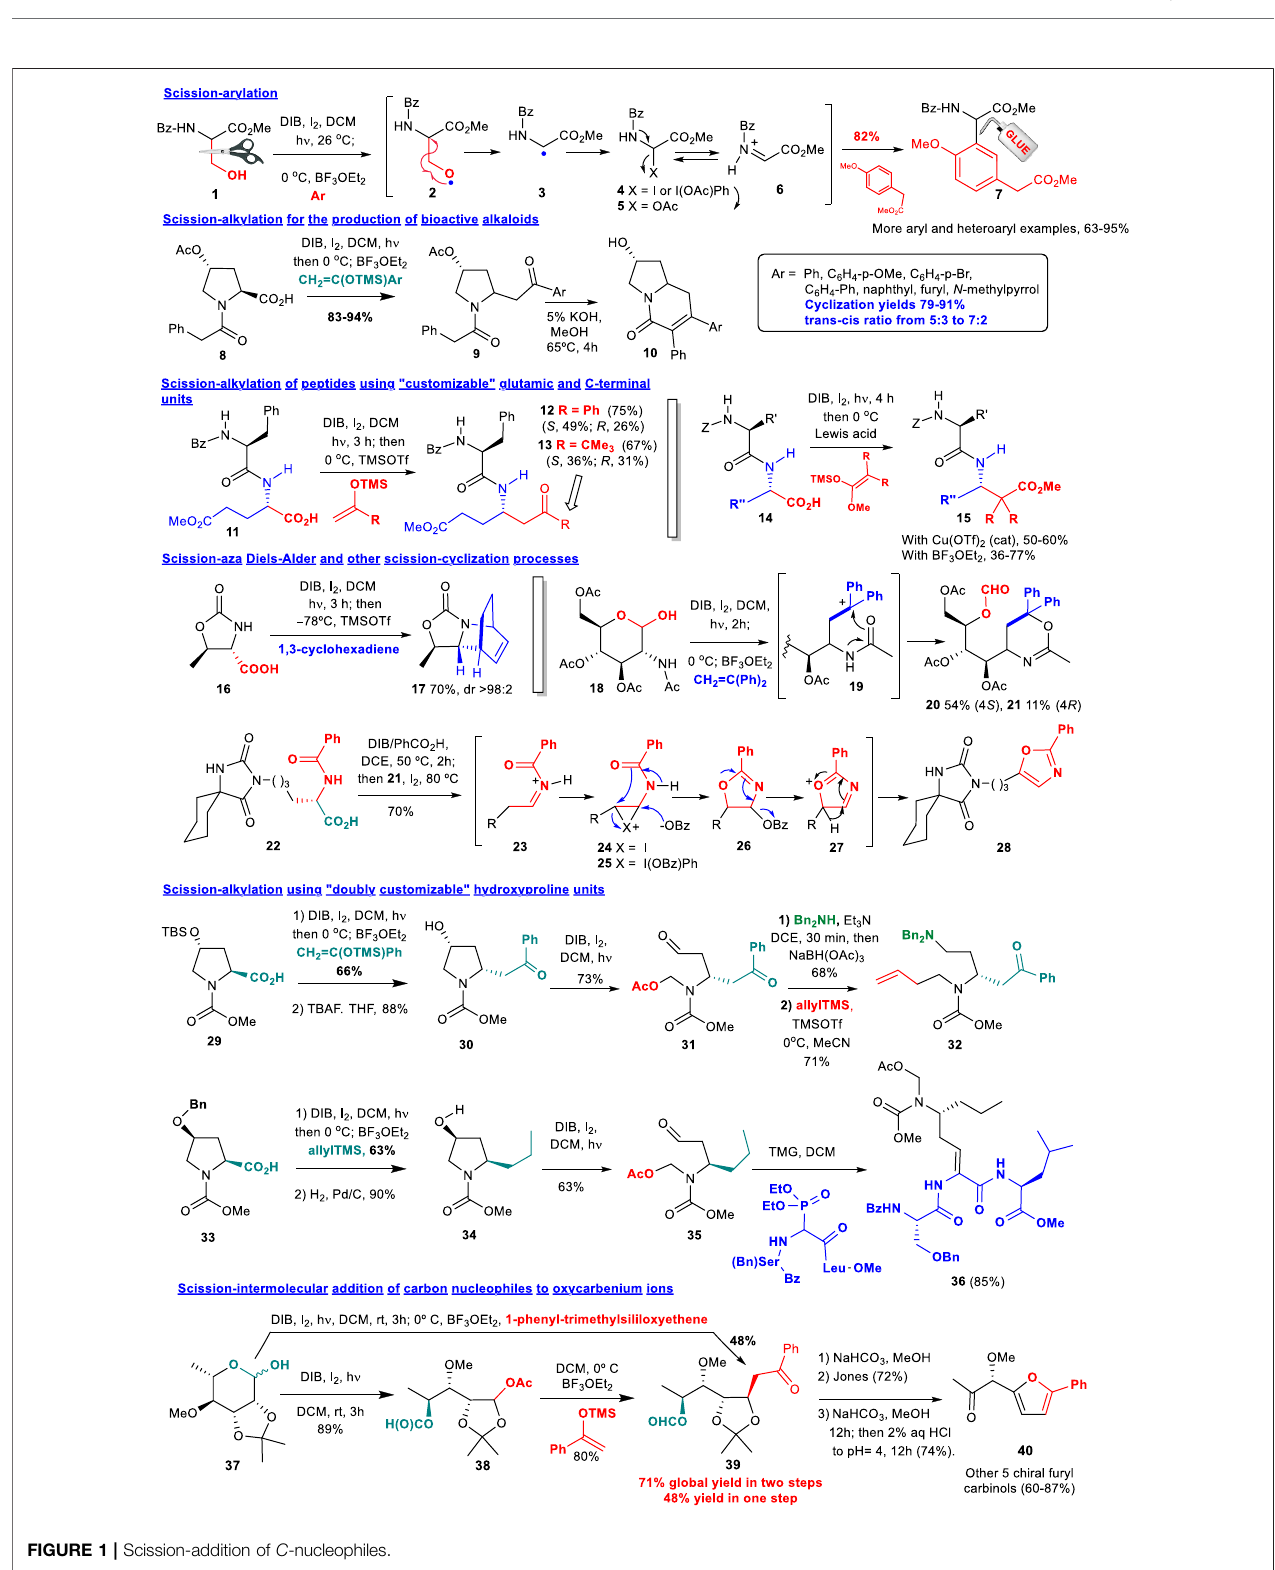
FIGURE 1 | Scission-addition of C -nucleophiles.